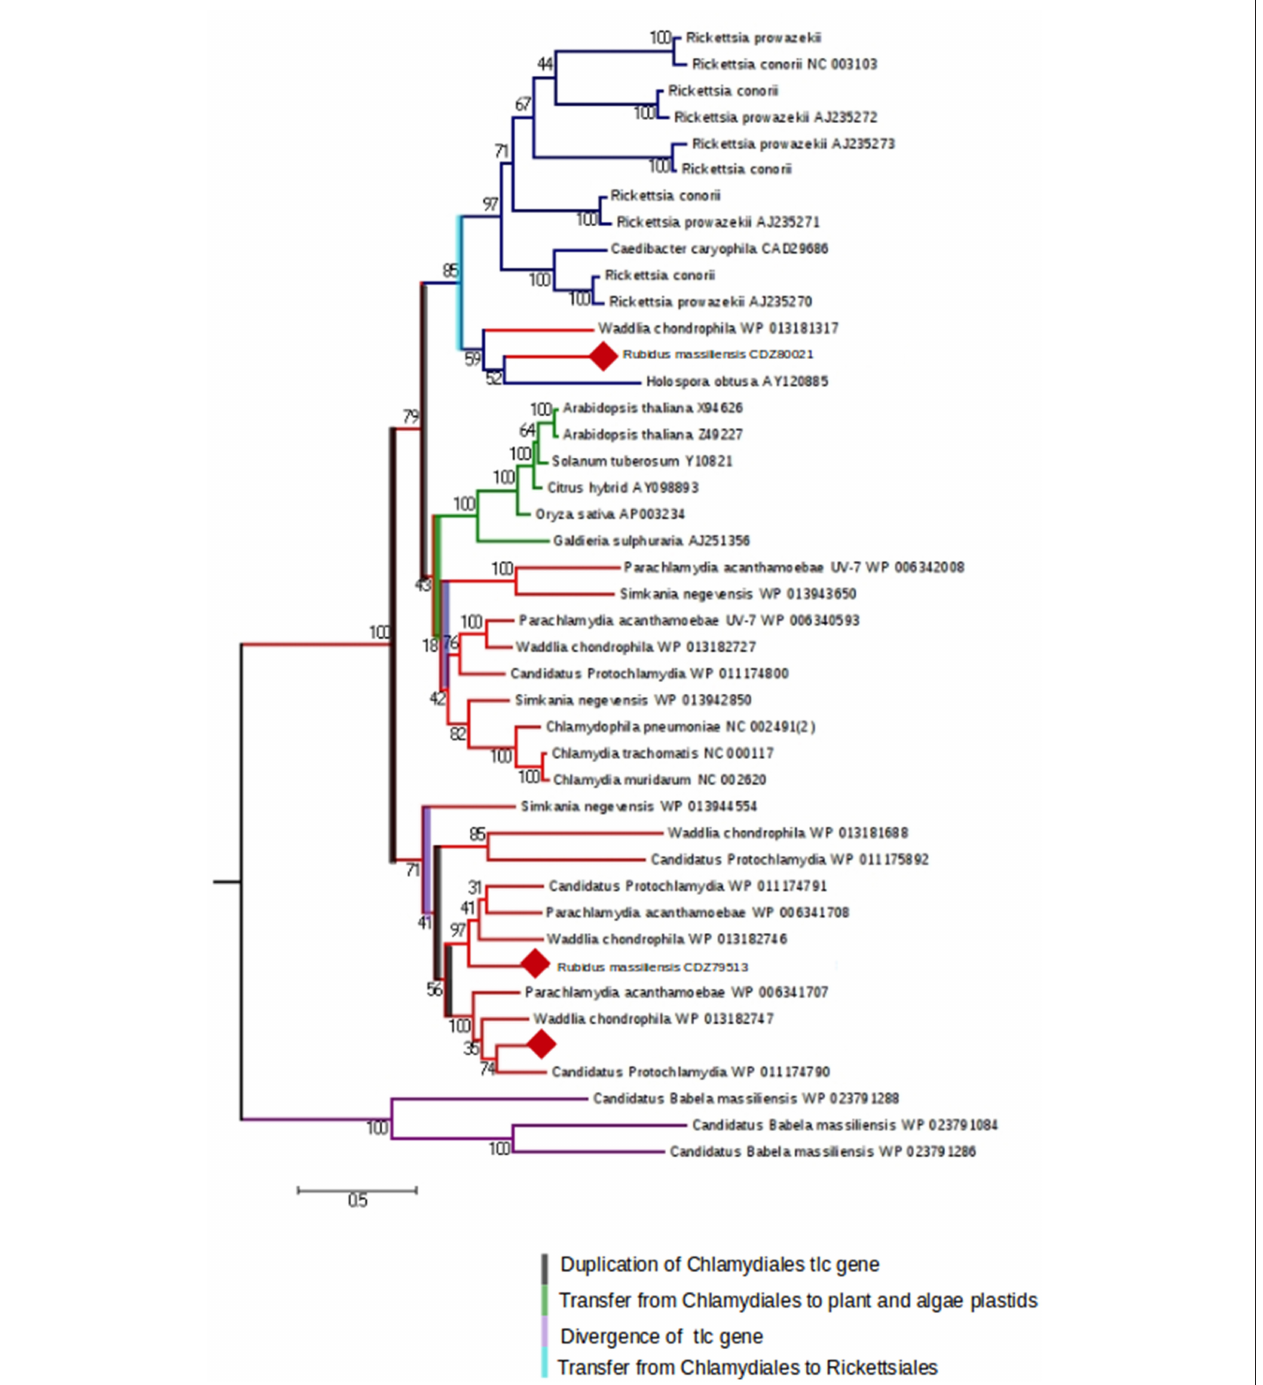
FIGURE 5 | The maximum-likelihood (PhyML) phylogenetic tree inferred from amino acid sequences of the ADP/ATP translocase of Parachlamydia acanthamoebae UV-7, Candidatus, Protochlamydia , Waddlia chondrophila , Simkania negevensis , R. massiliensis , Chlamydiaceae , Rickettsiales, and plant and algal plastids. Bootstrap proportion values are indicated at the node.